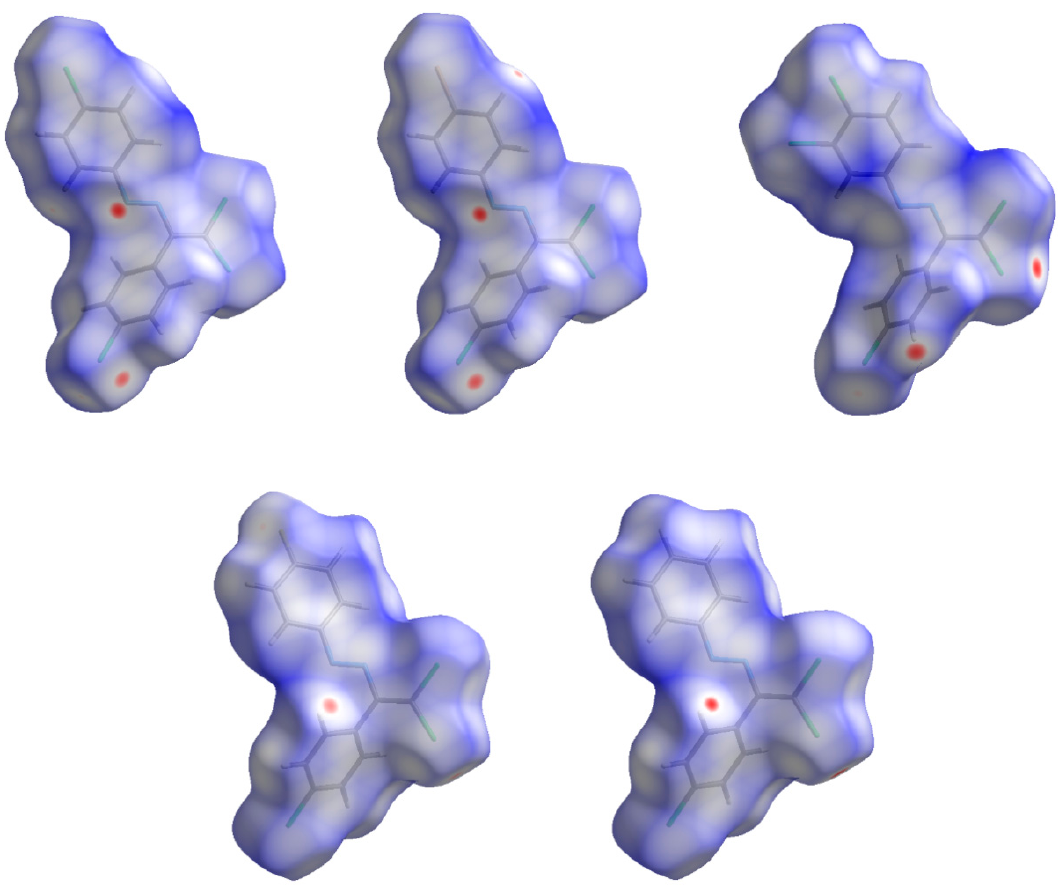
Figure 6. Visualization of Hirshfeld surfaces for X-ray structures 14 , 15 , and 17 (top), 13 and 10 (bottom).